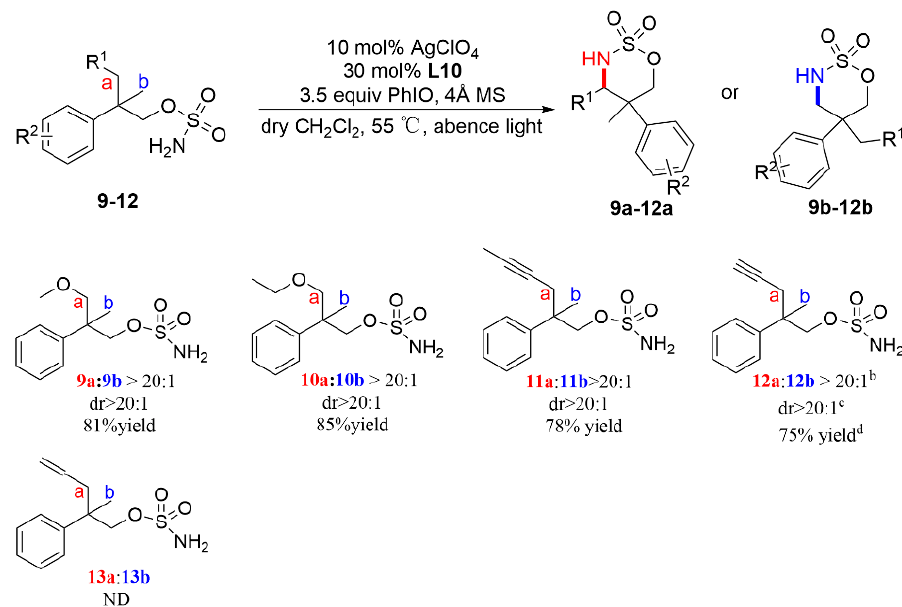
Figure 2. Selective amination of unactivated substrates a .